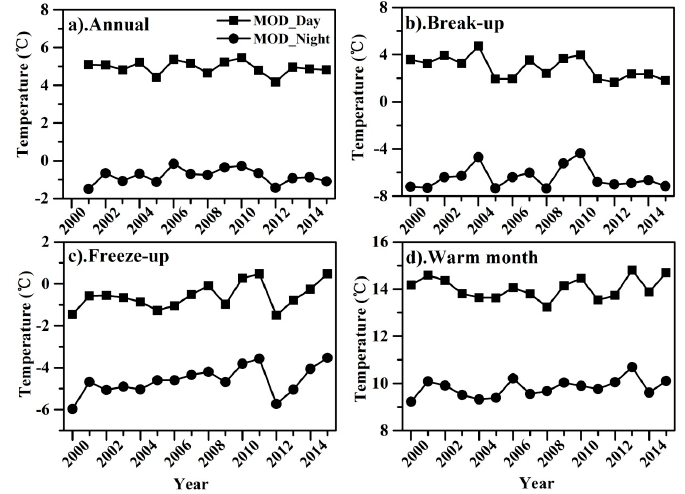
Figure 9. Inter-annual changes of lake-averaged annual daytime and nighttime water surface temperature (WST) of lakes from 2000 to 2015: ( a ) annual average; ( b ) break-up month; ( c ) freeze-up month; and ( d ) warm month.